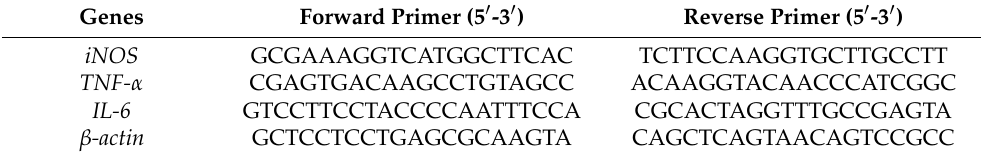
Table 1. Primers used for qPCR.